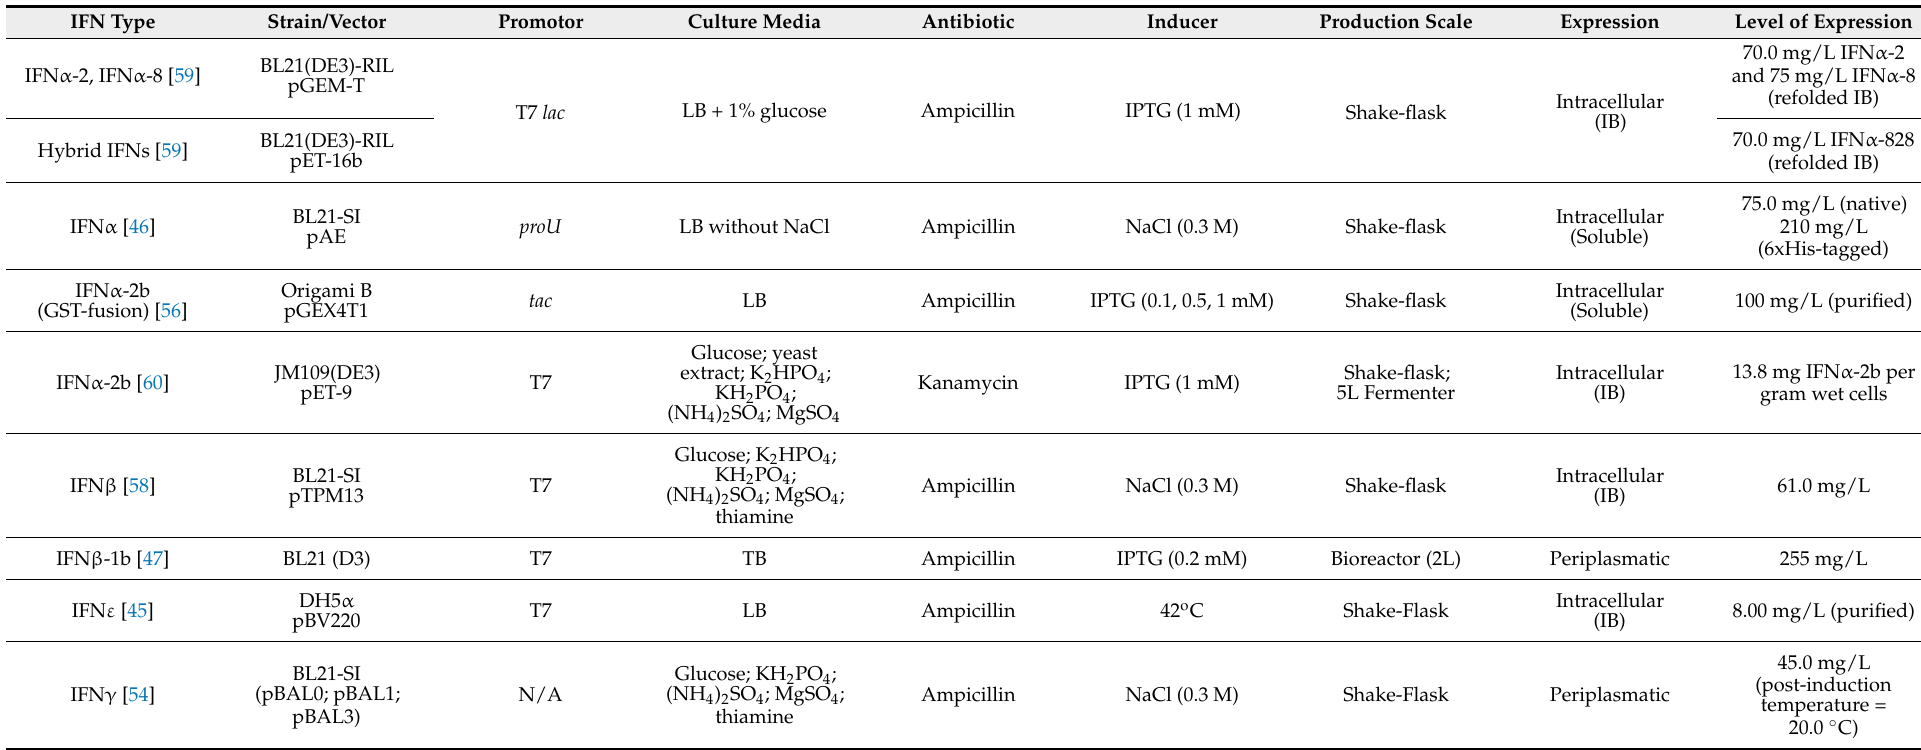
Table 3. Representative studies of the expression of therapeutic IFNs in Escherichia coli recombinant